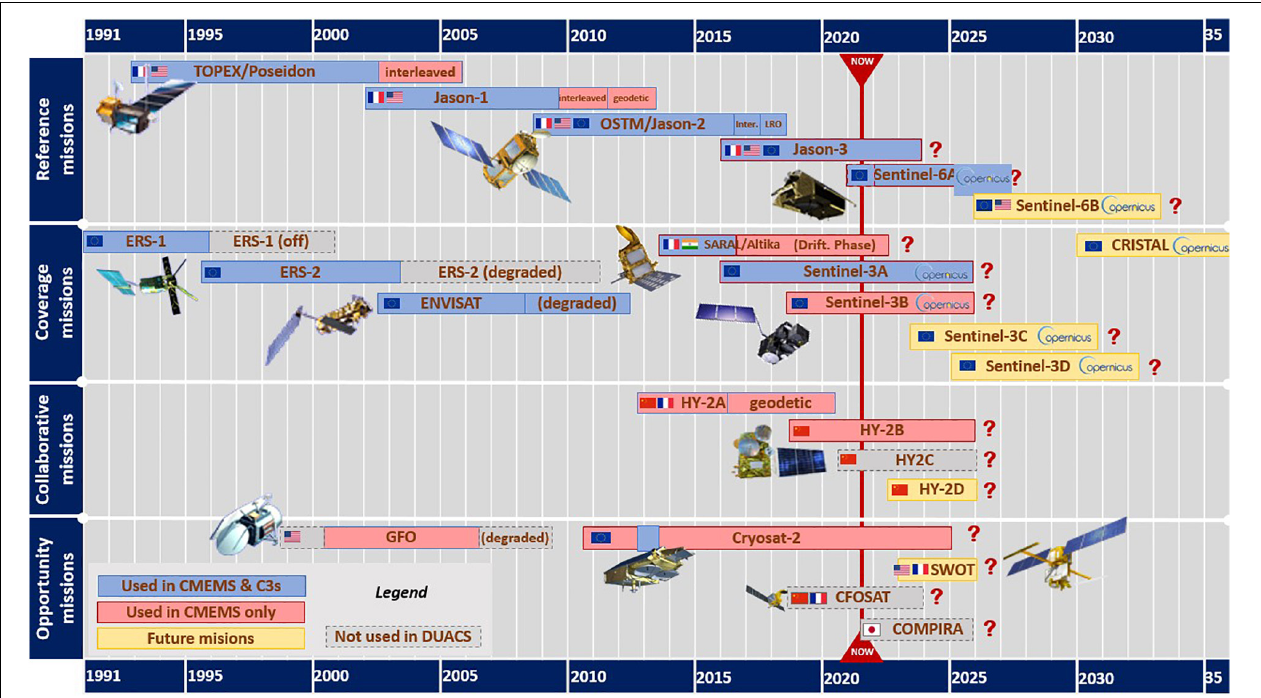
FIGURE 1 | Timeline of modern radar altimetry missions. Reference missions are used to ensure the stability of the sea level products and are distinguished from the coverage, collaborative and opportunity missions. The color of the labels of the different missions depends on their use in the different Copernicus altimeter sea level products (see section “Building Ready to Use Altimeter Sea Level